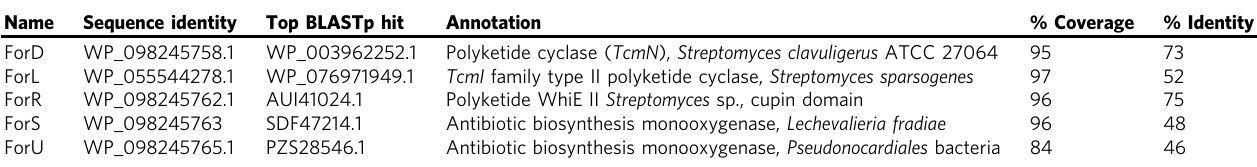
Table 1 Characteristics of the putative PKS cyclase genes in the for BGC